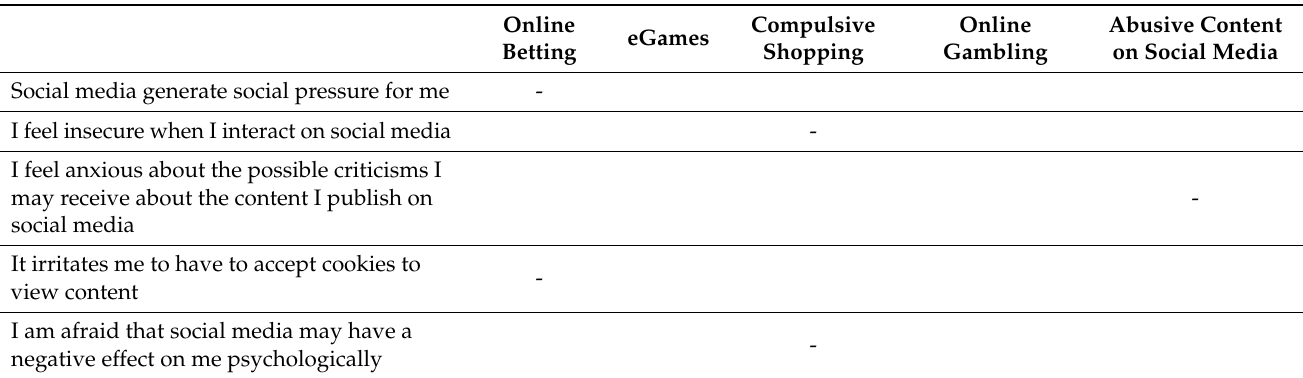
Table 8. Variables whose values indicating the lack of the item measured increase the probability of perceiving risk or danger in risky online